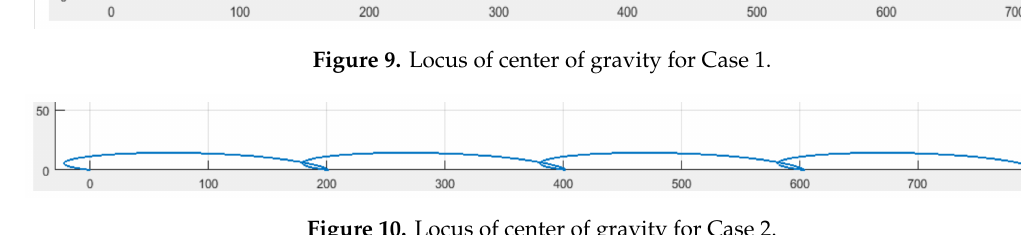
Figure 10. Locus of center of gravity for Case 2.